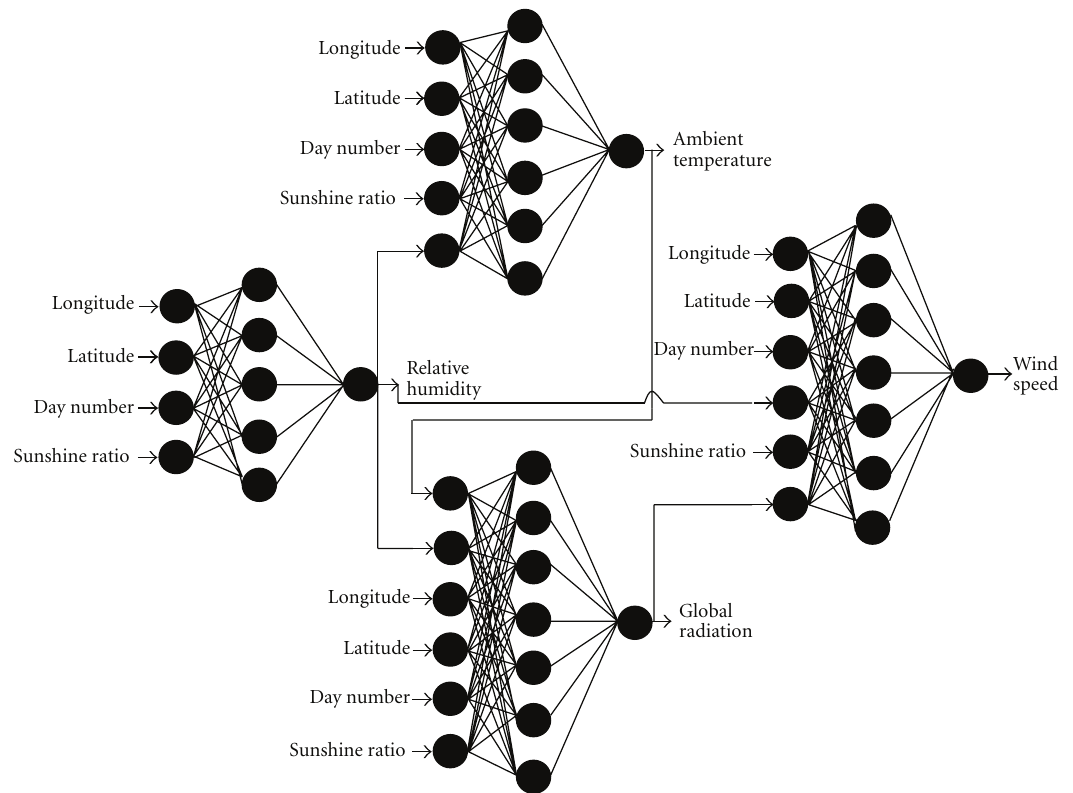
Figure 7: ANN based-model for meteorological variable prediction.